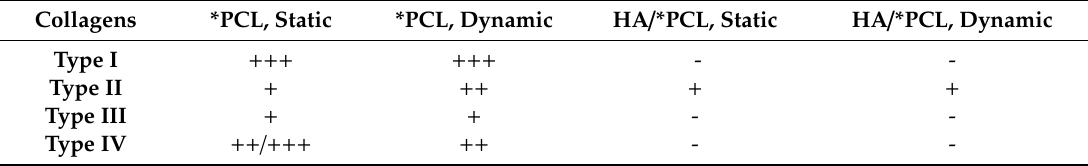
Table 3. Semi-quantitative evaluation of the immunopositivity for TM collagens as expressed by di ff erent hMSC / sca ff old (*PCL or HA / *PCL) constructs after di ff erentiation for seven days in di ff erent culture conditions (static or